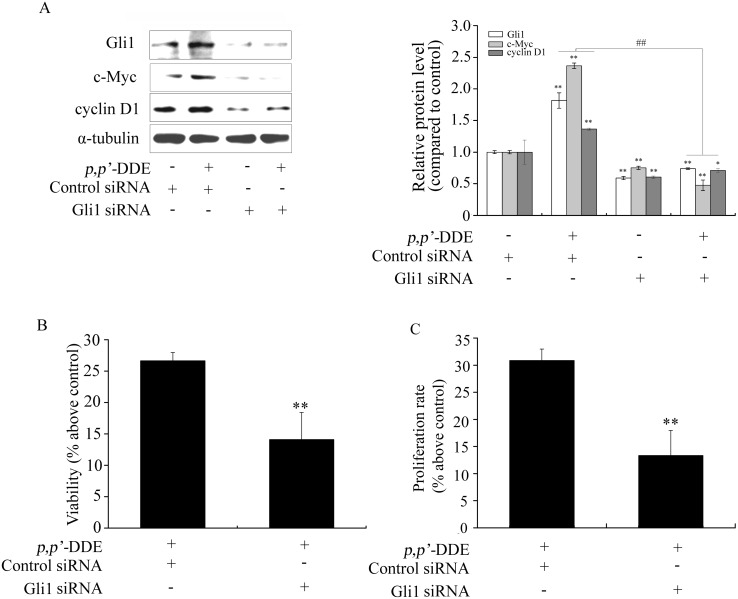
Inhibition of Hedgehog/Gli1 signaling blocks p,p′-DDE-induced DLD1 cell proliferation.After DLD1 cells were transfected with control siRNA or Gli1 siRNA, followed by treating with p,p′-DDE (10−9 M) for 96 h, (A) Protein levels of Gli1, c-Myc and cyclin D1 were examined by western blotting. α-tubulin was used as a control. Grayscale scan analysis of western blot bands from three independent experiments were shown in right panel of graph. *p<0.05 and **p<0.01 compared to the cells only transfected with control siRNA. ##
p<0.01 compared to the cells transfected with Gli1 siRNA along with p,p′-DDE treatment. (B) Cell viability and (C) proliferation rate were analyzed by MTT and cell number assays. The results are percent as the mean ± SD of three independent experiments. **p<0.01 compared to control.